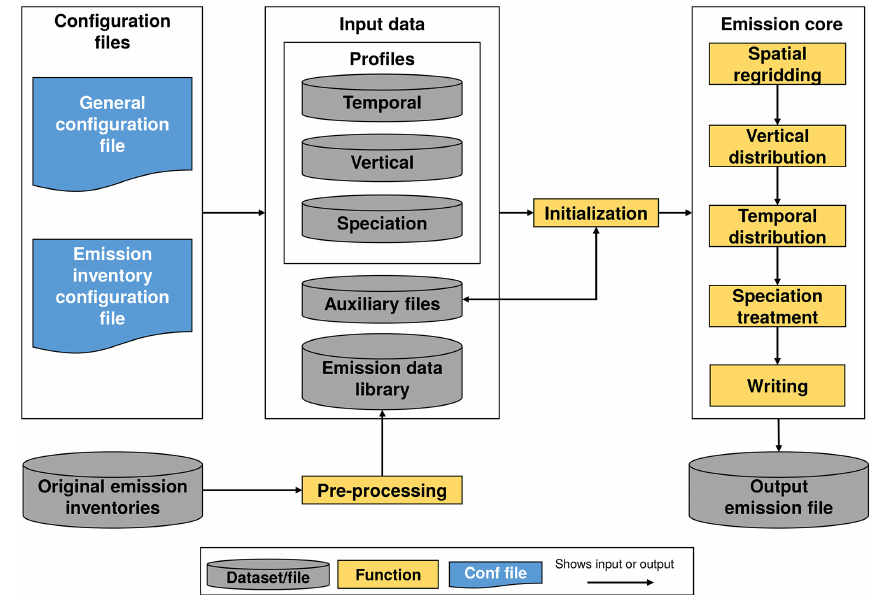
Figure 1. Schematic representation of the general structure of